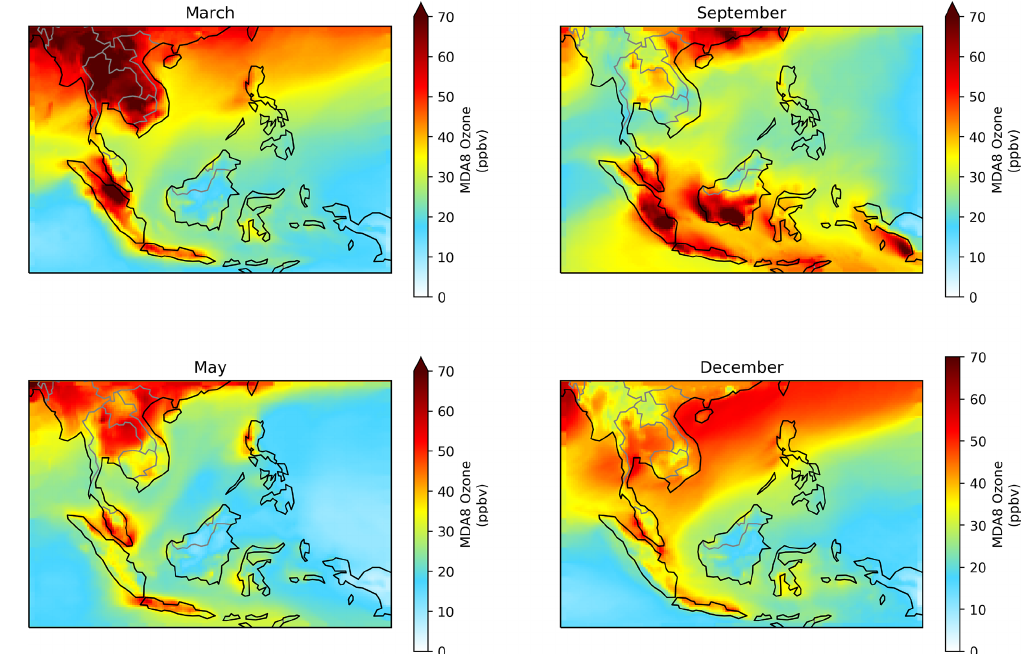
Figure 10. Spatial distribution of monthly mean MDA8 ozone (ppbv) calculated for Southeast Asia in March, May, September and De- cember 2014 based on surface concentrations of ozone from the GEOS-Chem nested model. For reference, the World Health Organization recommends an observed limit of (cid:39)